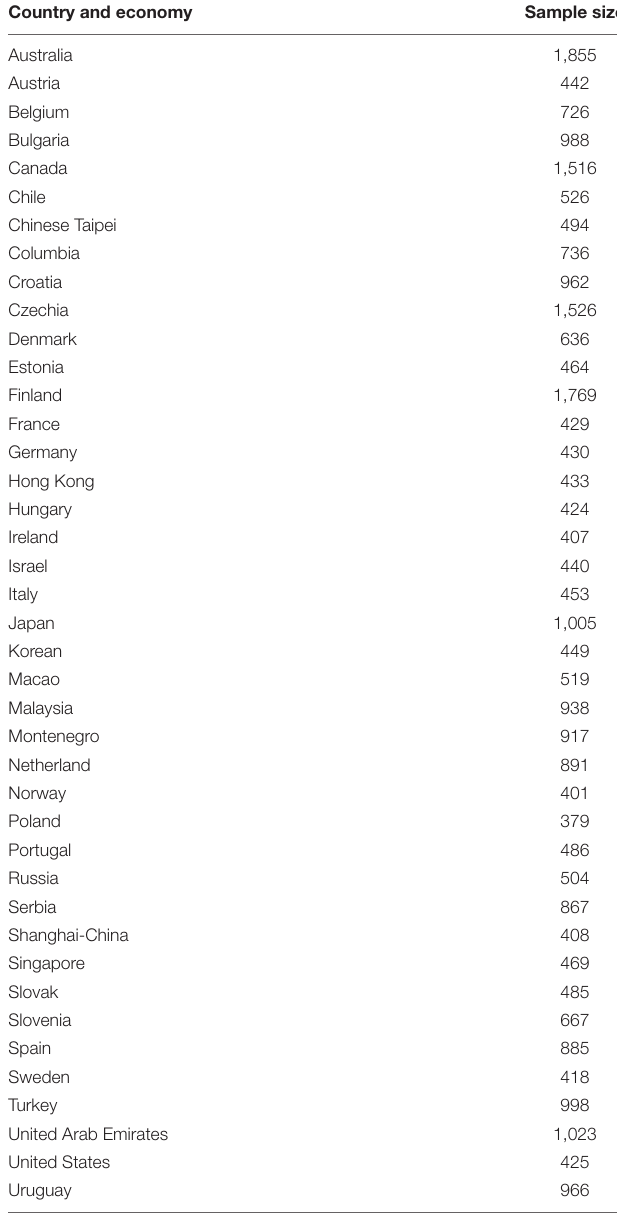
TABLE 1 | Countries and economies with sample